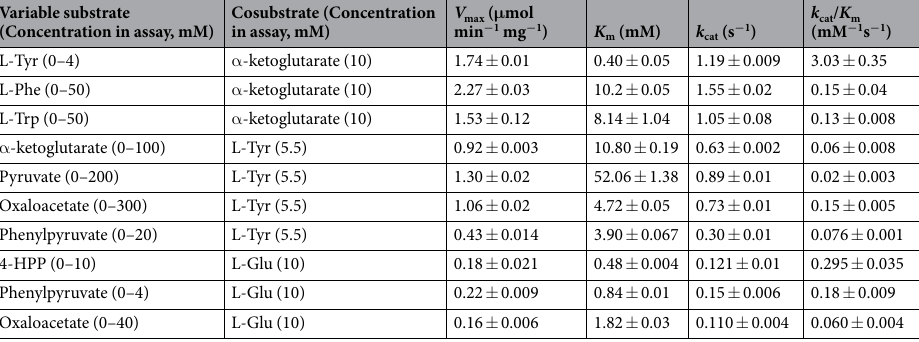
Table 1. Kinetic parameters for PvTAT. Data are presented as means ± SD of three replicates. The K m and V max values were calculated from the Michaelis-Menten equation using a non-linear regression method with curveexpert1.4. Note: For the calculation of k cat , a molecular weight of 65 kDa was assumed for the His-tagged TAT protein. And k cat was calculated by dividing V max by E t (the number [pmol] of enzymes in each assay). The assay measured the production of 4-hydroxyphenylpyruvate at 331 nm, phenylpyruvate at 320 nm, and indole- 3-pyruvate at 328 nm corresponding to the substrates L-tyrosine, L-phenylalanine, and L-tryptophan. For the reverse direction, the assay measured the production of NADH at 340